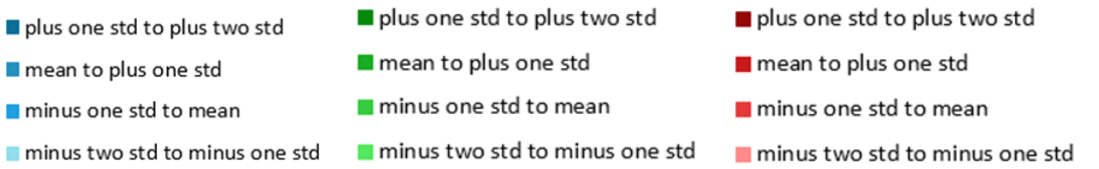
Figure 8. MOBY and Venice AERONET-OC in situ nLw climatologies with Planet nanosatellite nLw predictions. Top left : MOBY in situ nLw_494. Top right : MOBY in situ nLw_545. Middle left : MOBY in situ nLw_635/644. Middle right : Venice AERONET-OC in situ nLw_490. Bottom left : Venice AERONET-OC in situ nLw_555. Bottom right : Venice AERONET-OC in situ nLw_668. The orange ‘x’ indicates a nanosatellite nLw predicted value.